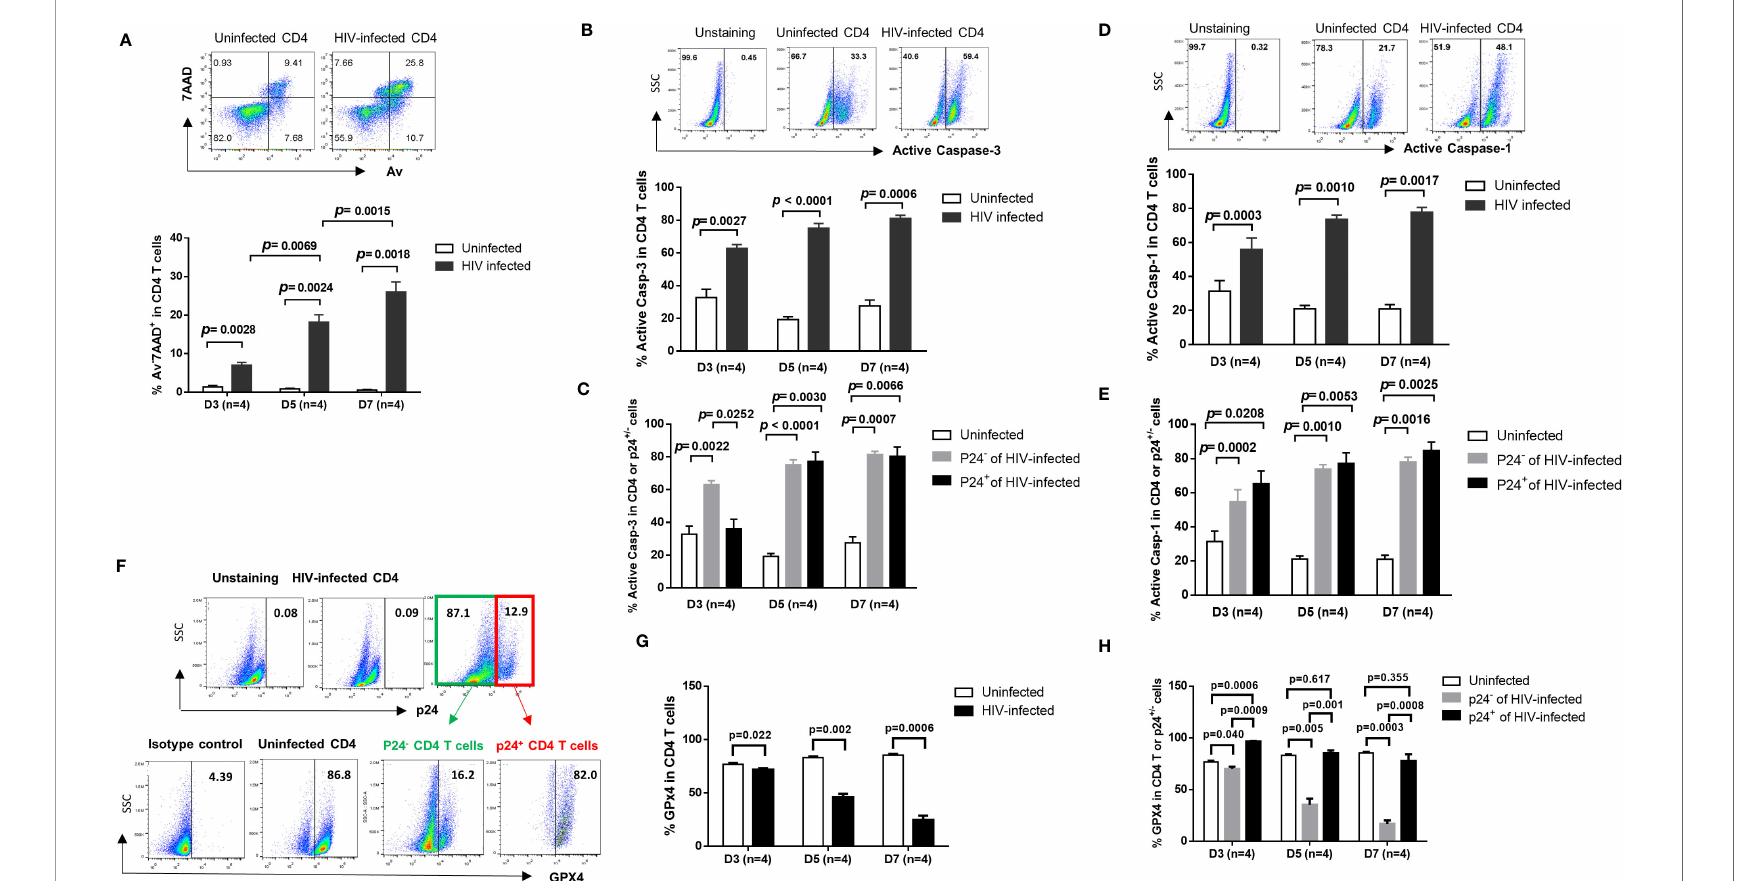
FIGURE 1 | HIV induces CD4 T cell death in productively infected and bystander cells during early infection via different mechanisms. (A) Representative dot plots (day 7) and summary of the percentage (%) of Av and 7AAD levels in HIV-infected and uninfected CD4 T cells, as determined by fl ow cytometry. (B, C) Representative dot plots and summary data showing active caspase-3% in productively HIV-infected (p24 + ) and bystander (p24 - ) or uninfected cells at days 3, 5, and 7 in cultures. (D, E) Representative dot plots and summary data of active caspase-1% in HIV-infected (p24 + ) and bystander (p24 - ) or uninfected cells at day 3, day 5, and day 7. (F – H) Representative dot plots and summary data of GPX4% in HIV-infected (p24 + ) and bystander (p24 - ) or uninfected cells at days 3, 5, and